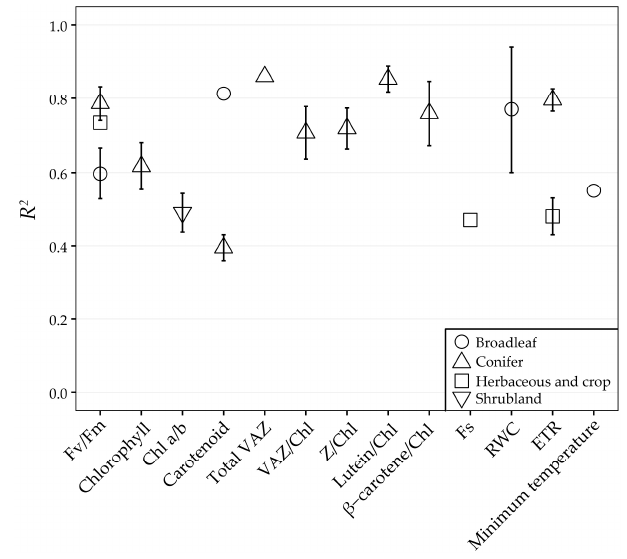
Figure 4. The mean values of coefficients of determination of the relationships between several physiological variables and PRI at the foliar level and seasonal timescale. All the correlations were significant ( p < 0.05). Error bars indicate standard